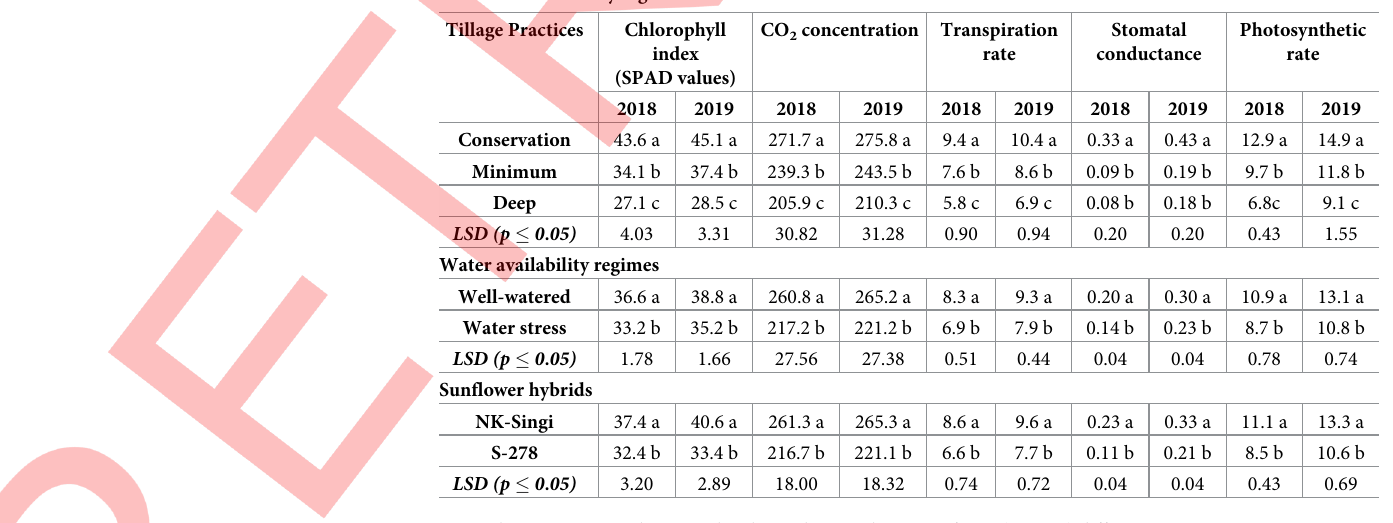
Table 4. Chlorophyll contents and physiological attributes of two sunflower hybrids as affected by tillage practice and water availability regimes. Tillage Practices (SPAD